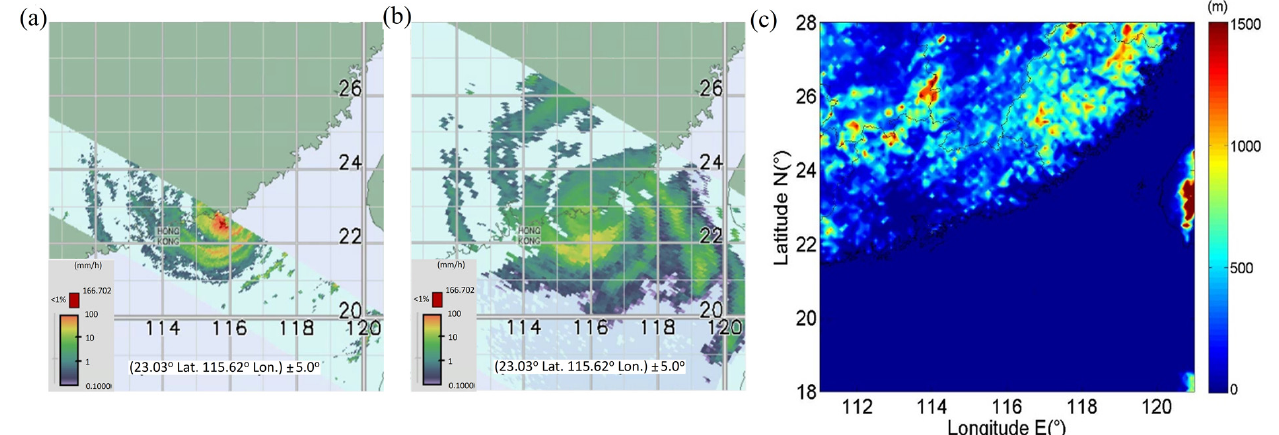
Figure 1. Snapshots of instantaneous rainfall intensity fields (extracted from TRMM) and the corresponding digital elevation map: ( a ) snapshot for 23 July 2014, at latitude = 26.20°, and longitude = 118.23°; the track and wind field parameter corresponding to the snapshot are the Holland B parameter equal to 1.26, R max = 37.79 (km), central difference pressure Δ p = 20.44 (hPa), translation velocity | u c | = 6.34 (m/s) and Intensity Category (IC) = 2, and translation angle equals 322.05°. ( b ) snapshot for 22 September 2013, at latitude = 22.65°, and longitude = 116.01°; the track and wind field parameter corresponding to the snapshot are the Holland B parameter equal to 1.61, R max = 13.38 (km), central difference pressure Δ p = 78.38 (hPa), translation velocity | u c | = 7.13 (m/s) and Intensity Category (IC) = 6, and translation angle equals 286.19°, and ( c ) digital elevation map corresponds to the snapshots shown in ( a,b ).